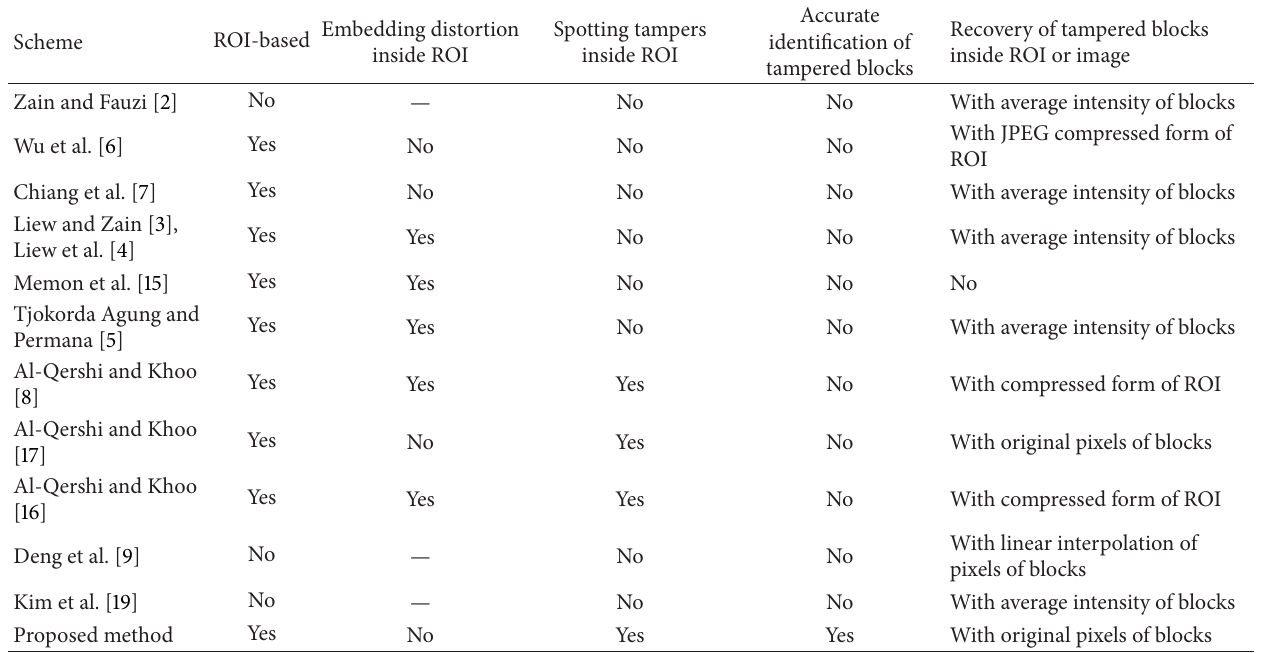
Table 5: Comparison between the proposed scheme and reviewed